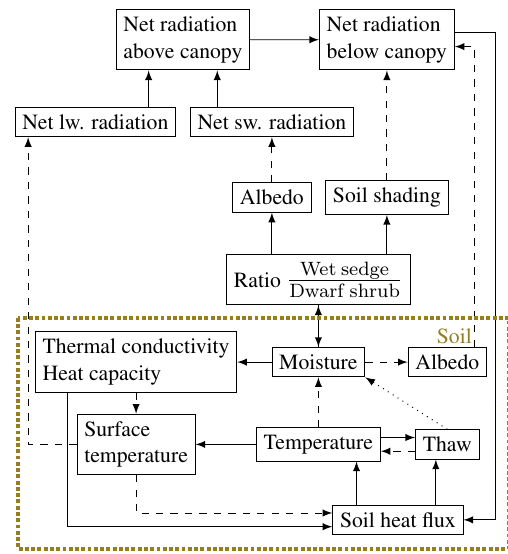
Figure 10. Different vegetation types are associated with soil prop- erties and soil heat fluxes (brown box), the radiation budget above and below canopy. Latent and sensible heat fluxes are not included as they were not measured in this study and effect directions are unclear. Permafrost thaw can feed back to soil moisture, but the di- rection of the effect depends on ice content and drainage conditions. Solid arrows represent positive, dashed arrows negative, and dotted arrows unknown feedback; lw. and sw. denote longwave and short- wave,